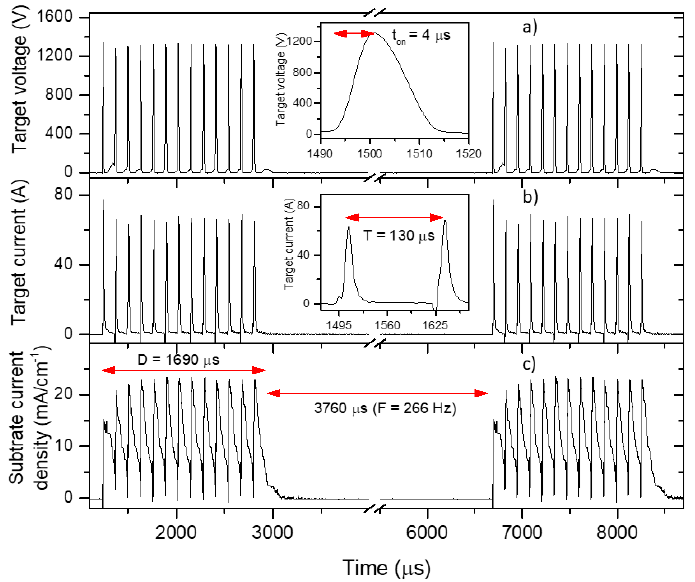
Figure 1. Typical deep oscillation magnetron sputtering (DOMS) target voltage ( a ) and target current ( b ) oscillating waveforms obtained by sputtering a carbon target in pure Ar. Each pulse consists of 13 oscillations separated by 130 µs, as shown in the insets. The corresponding substrate current density ( c ) measured with the flat probe with a polarizing voltage of − 90 V (P = 0.7 Pa; DCint = 400 V; F = 266 Hz; D = 1690 µs; ton = 4 µs; T = 130 µs).